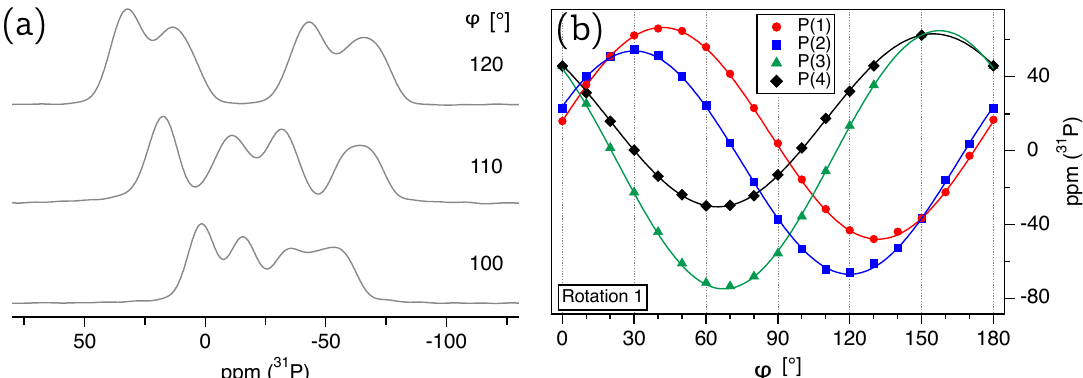
Figure 2. (a) Single crystal of aluminum nitride, AlN, from Leibniz Institute for Crystal Growth (IKZ, Figure 2. ( a ) 31 P NMR spectra of the LDP single crystal, with the indicated rotation angles ϕ referring Berlin), with the crystallographic c axis and ab plane indicated by arrows.[10] (b) Wurtzite structure to the full rotation pattern on the right. ( b ) Full rotation pattern over 180 o for the four magnetically of AlN, according to Reference [9], viewed down the crystallographic (11-20) direction. The aluminum inequivalent 31 P at Wyckoff position 4 a , acquired by rotating the LDP crystal counter-clockwise by 10 o atoms (grey) and the nitrogen atoms (yellow), both located at Wyckoff position 2 b , are tetrahedrally around the goniometer axis (cid:126) g 1 . The lines represent the fit of the experimental points to the CS tensor coordinated by each other with one Al-N bond directed parallel to the crystallographic c axis. (c) Individual, elements and axis orientation (see text for tetrahedrally coordinated, aluminum and nitrogen atom in the crystal structure of AlN, in which the three equal, shorter, bonds Al/N—I/II/III [1.8891(8) Å] and the longer bond Al/N—IV [1.9029(16) Å] along the three-fold rotation axis are highlighted. a Drawing generated with the Vesta program [11].